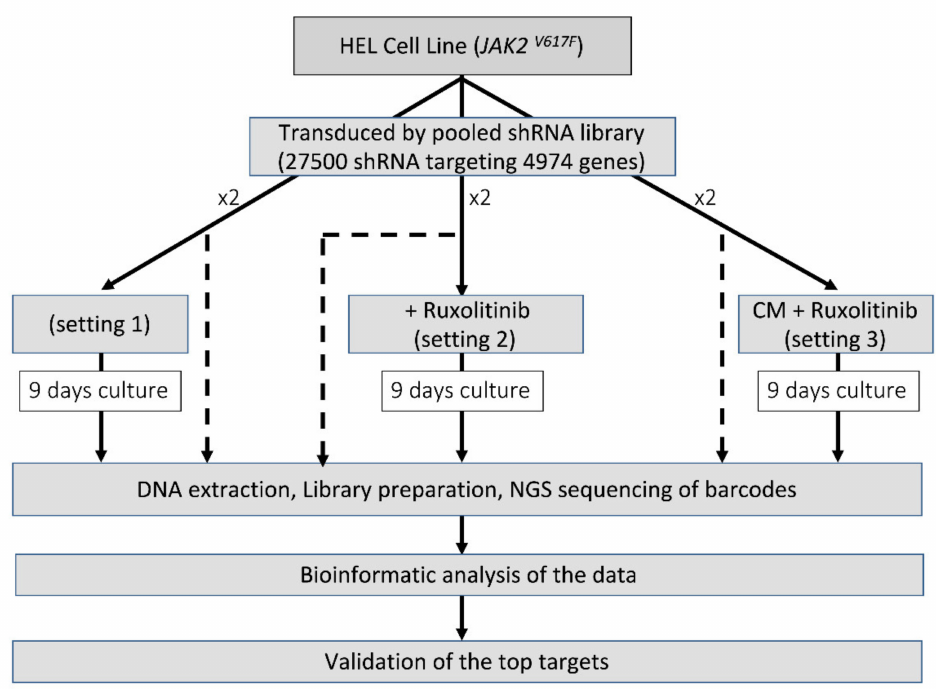
Figure 1. Identification of the essential survival genes in different settings. For each setting, before the selection period in culture, one third of the cells were stored to represent the shRNA frequency in the transduced cells (shown as